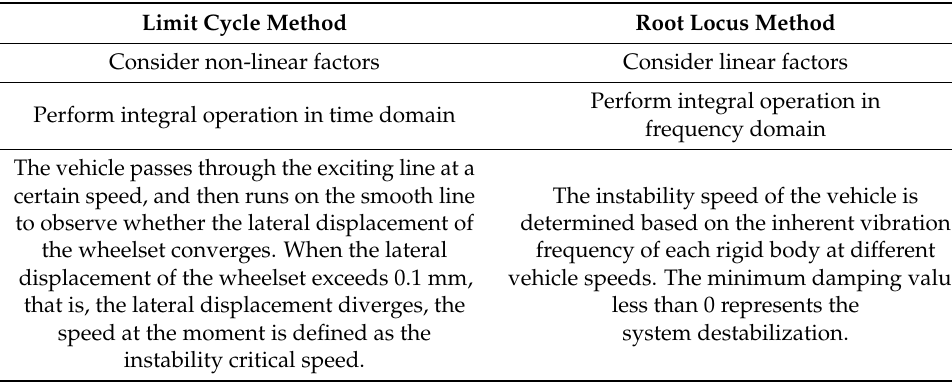
Table 3. The limit cycle method and root locus method.